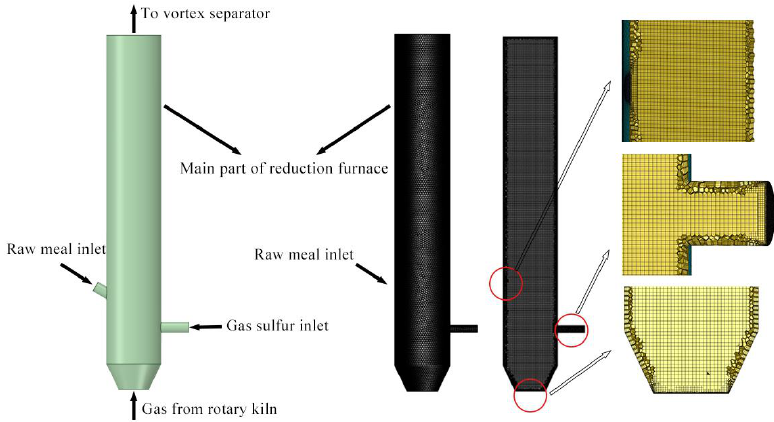
Figure 1. Structure, grid, and local densification diagram of reduction furnace.